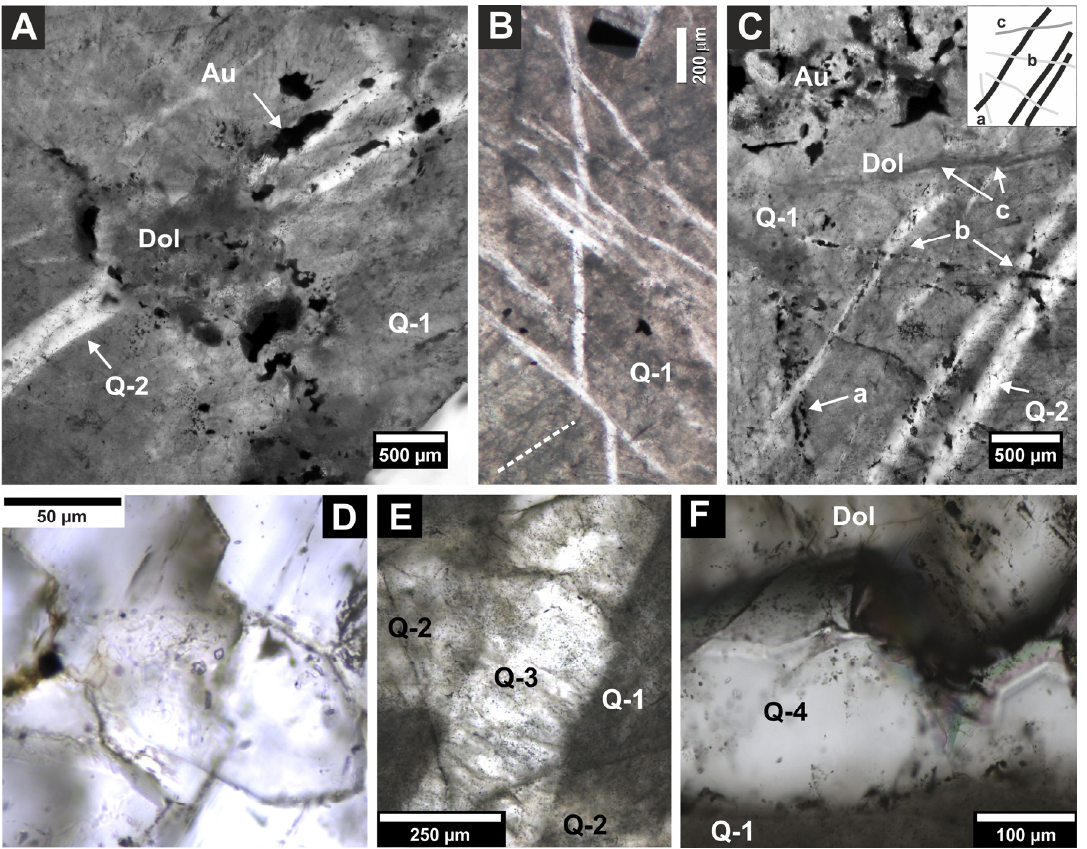
Figure 4. Microphotographs of gold-bearing quartz gangue: ( A – C ) Poorly transparent quartz (Q-1) crosscut by carbonate (Dol) and quartz (Q-2) veinlets. The black opaque phases largely correspond to gold and Bi-Te phases. Note that some quartz-2 veinlets host the gold (Au). ( C ) Complex crosscutting relationships between the quartz-2 and dolomite (Dol) veinlets. ( D ) Detailed image of a veinlet crosscutting oldest quartz (Q-1) composed of subhedral crystals of quartz-2. ( E ) Crosscutting relationship between the quartz Q-1, Q-2, and Q-3. ( F ) Euhedral crystals of the latest quartz (Q-4) on the edge of dolomite–ankerite (Dol) veinlet.